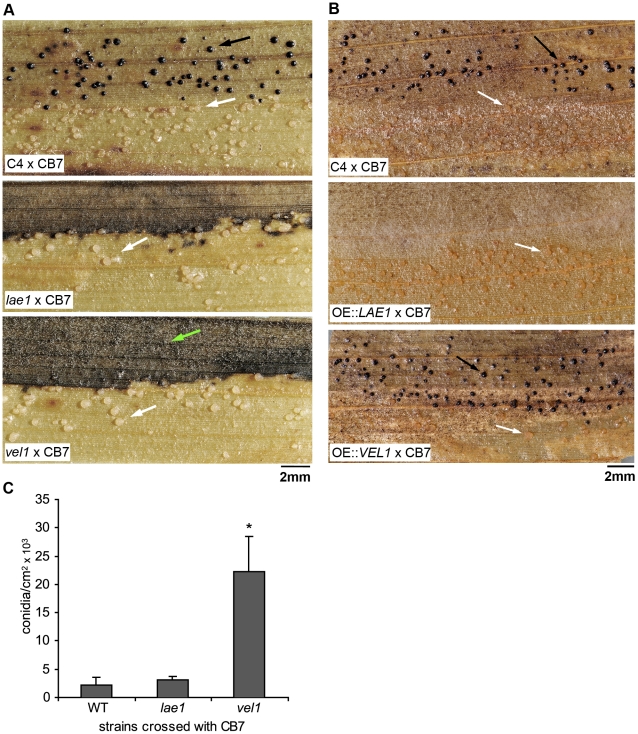

Chlae1 and Chvel1 mutants are compromised in reproductive development.
A.
Chlae1 and Chvel1 mutants are female sterile. Top: a control cross between pigmented WT strain C4 and albino WT strain CB7. Both black and white pseudothecia (arrows) are produced indicating both strains are hermaphroditic. Middle and bottom rows: crosses between albino WT strain CB7 and pigmented Chlae1 or Chvel1, respectively. Only white pseudothecia (arrows) are produced, indicating the mutant strains are female sterile (color of pseudothecia reflects strain acting as female). Heavy black region (green arrow) on bottom image indicates profuse production of pigmented conidia of the Chvel1 mutant. B.
ChVEL1 overexpression strains are more fertile than WT strains. Crosses with ChVEL1 OE strains produce both pigmented and white pseudothecia (bottom panel, arrows) at a ratio of 2∶1 while a WT cross produced nearly equal numbers of pigmented and white pseudothecia (top panel). ChLAE1 OE strains are female sterile (middle panel, white pseudothecia only), like Chlae1 mutants. C. Asexual sporulation is de-repressed in the Chvel1 mutant during mating. The average numbers of asexual spores formed on cross plates are shown. Error bars are standard deviation. Asterisks indicate p-value <0.05 in T-test analysis in which each strain was compared with WT C4. WT strain C4 and the Chlae1 mutant strain produce few vegetative spores during sexual reproduction, while asexual sporulation is de-repressed in the Chvel1 mutant (see also bottom panel in A, green arrow).